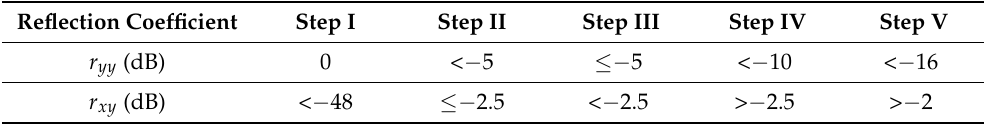
Table 2. Proposed polarisation converter design steps with corresponding co-pol ( r yy ) and